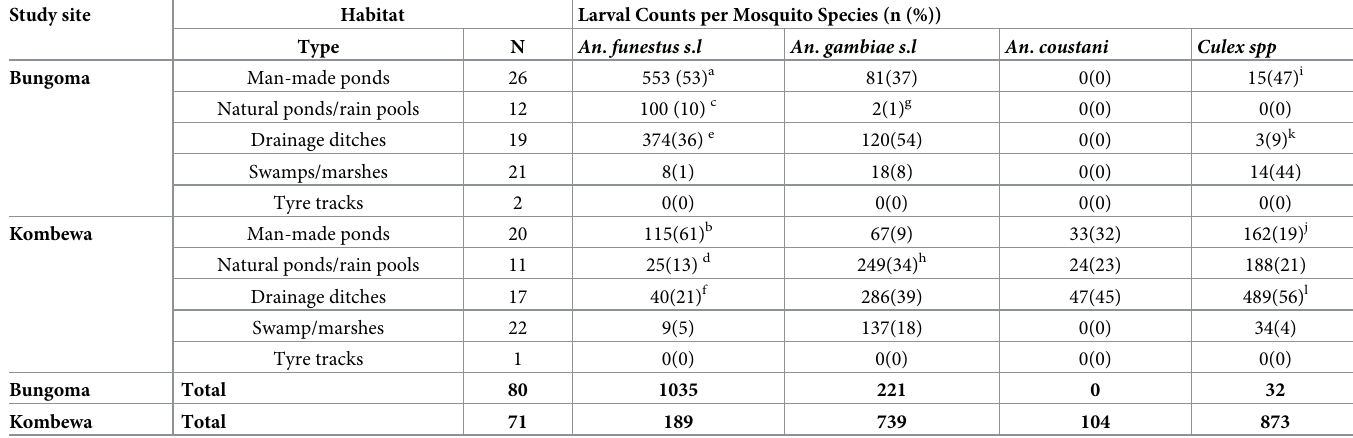
An . funestus larvae were found in various habitats, with or without vegetation: man-made ponds, natural ponds/rain pools, drainage ditches, swamp/marshes, and tyre tracks. There were no significant differences in An . funestus larval density between the various habitat types of An . funestus ( χ 2 = 8.917, df = 4, P = 0.063). However, man-made ponds comprised the high- est number of An . funestus positive habitats (36%, n = 28) and had the highest proportion of larvae with An . funestus in Bungoma (53%, n = 553) and in Kombewa (61%, n = 115) (Table 1). The larval abundance of An . funestus in man-made ponds, natural ponds/rain pools and drainage ditches was significantly different between the study sites ( P < 0.05) (Table 1). Field observations showed that man-made ponds constituted the main permanent aquatic habitat type in the study areas. This was followed by swamp/marshes, natural ponds/rain Table 1. Number of different mosquito species collected from aquatic habitats in Bungoma and Kombewa in Kenya in the months of November 2019 to November 2020. Study site Habitat Larval Counts per Mosquito Species (n (%)) Type N An . funestus s .